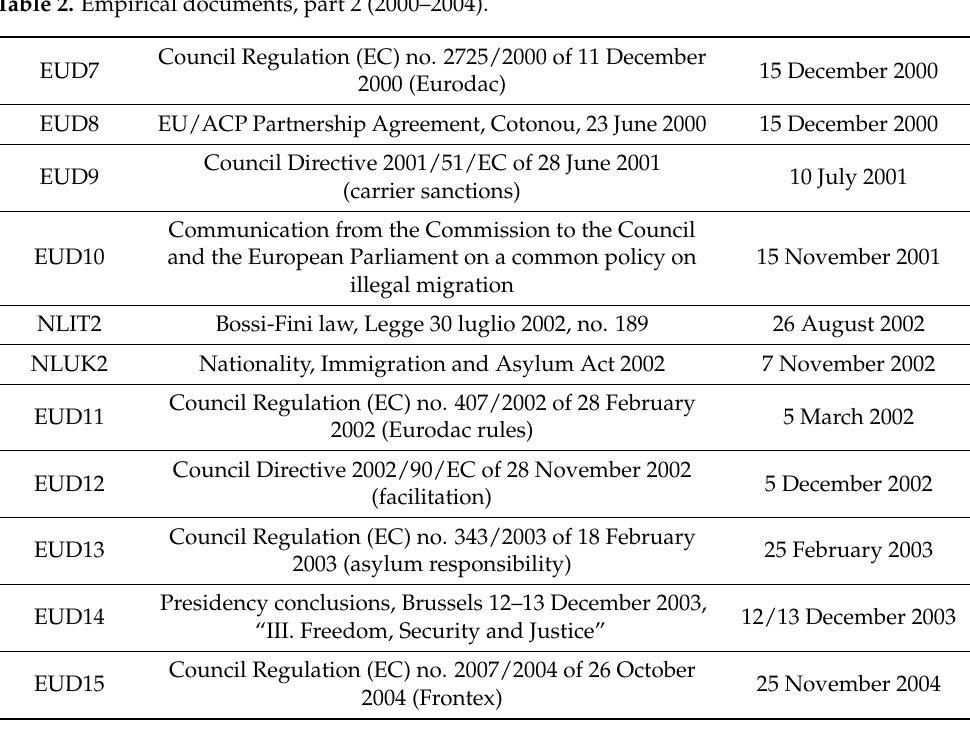
Table 2. Empirical documents, part 2 (2000–2004).